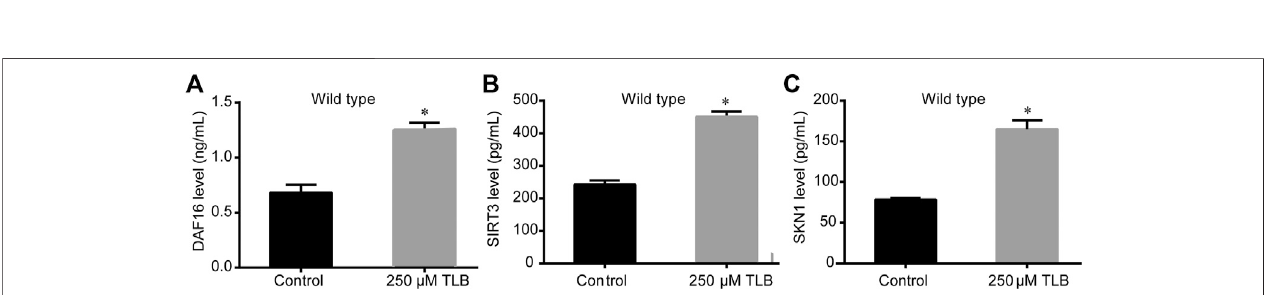
FIGURE8| TLBincreasedtheproteinexpressionsofDAF16,SIRT3andSKN1ofWT C.elegans . C.elegans wereraisedintheabsenceorpresenceof250 μ MTLB for72 h.Thetotalproteinof C.elegans wasextracted andcentrifugedfor10 minat10,000 × g,at4 ° C,thenthesupernatant wasdetectedusingappropriateELISAkits. (A) DAF16 level (B) SIRT3 level (C) SKN1 level. ( n (cid:2) 1000). Data were presented as mean ± SEM. * p < 0.05 vs. non-TLB treated